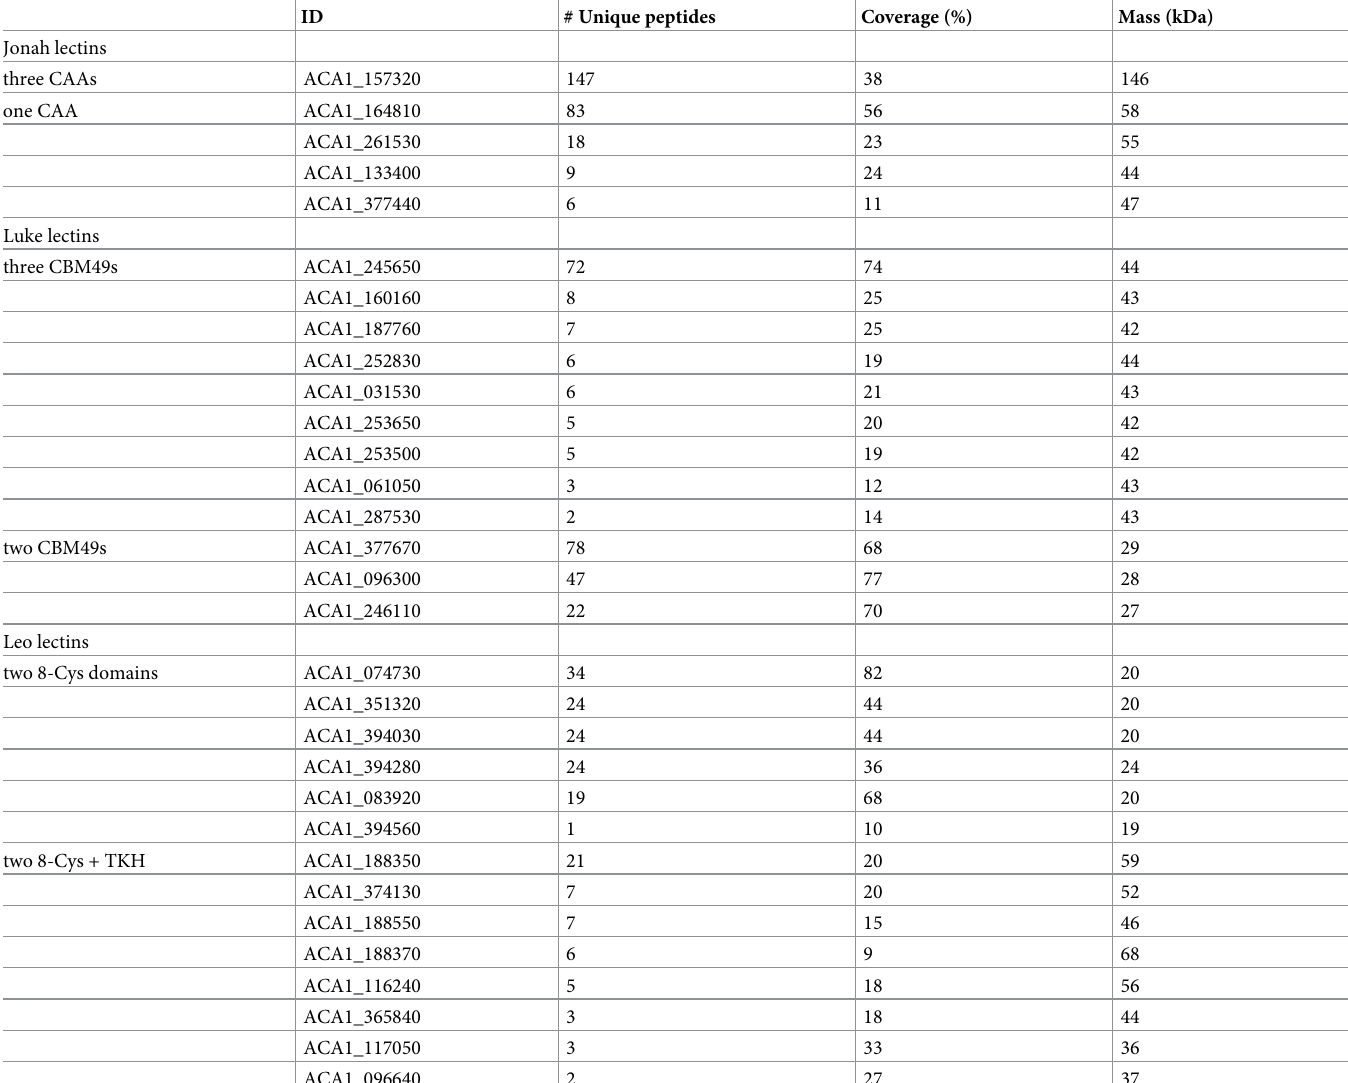
Table 1. Candidate cyst wall proteins of A . castellanii identified by mass